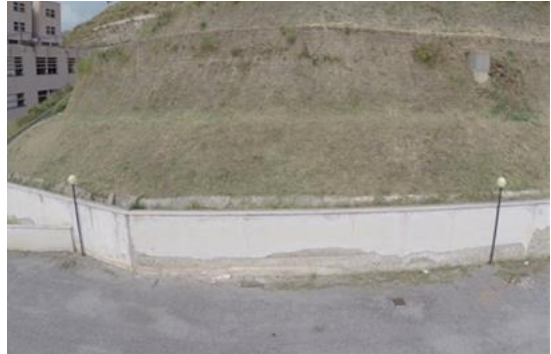
Figure 4. Example of image shot by UAV